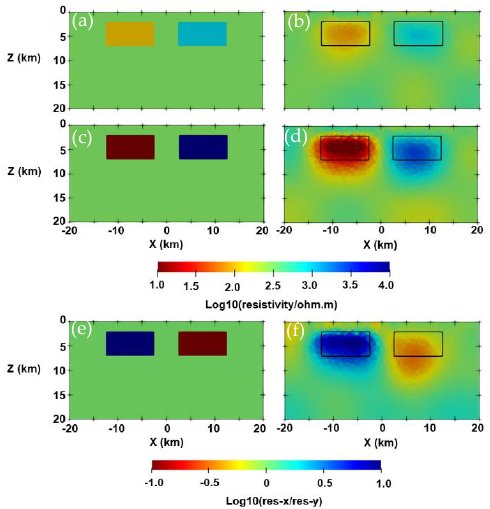
Figure 11. Anisotropic inversion results at y = 0 km. Panels ( a ), ( c ), and ( e ) show the true model for the principal X, Y directions and the anisotropic coefficient. Panels ( b ), ( d ), and ( f ) show the corresponding inversion results.